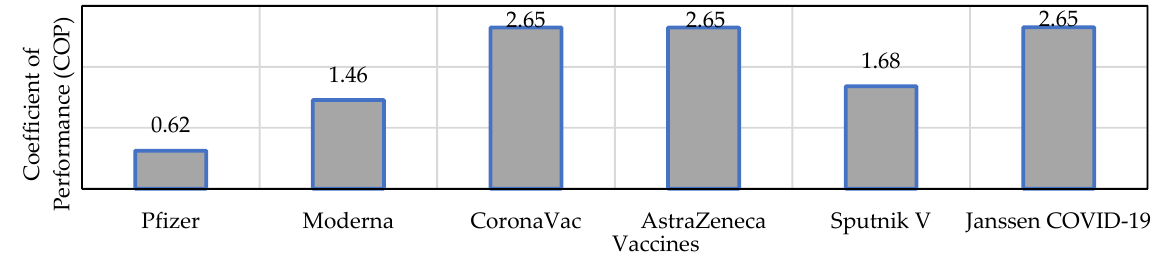
Figure 2. COP of refrigeration systems with evaporator and condenser fans for vaccines.